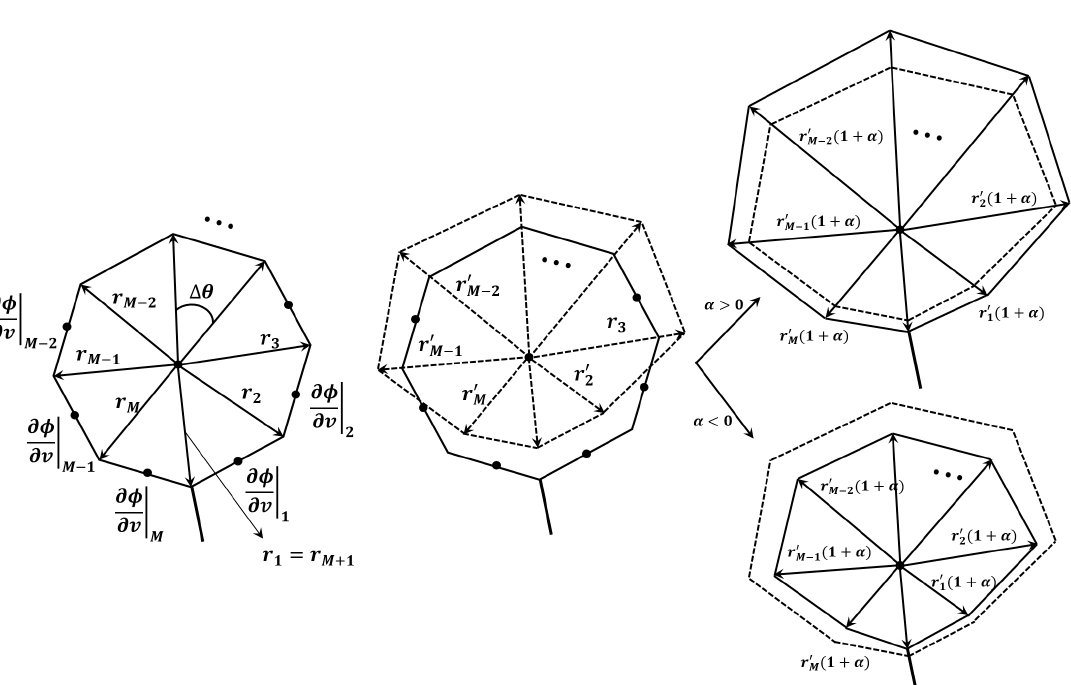
Figure 8. Adjusting tip vortex radii from the initial shape ( left ). Kinematic boundary condition (Equation (27)) updates the radius in radial direction ( middle ), and the potential jump condition expands or contracts the overall shape, depending on the sign and the magnitude of the α ( right